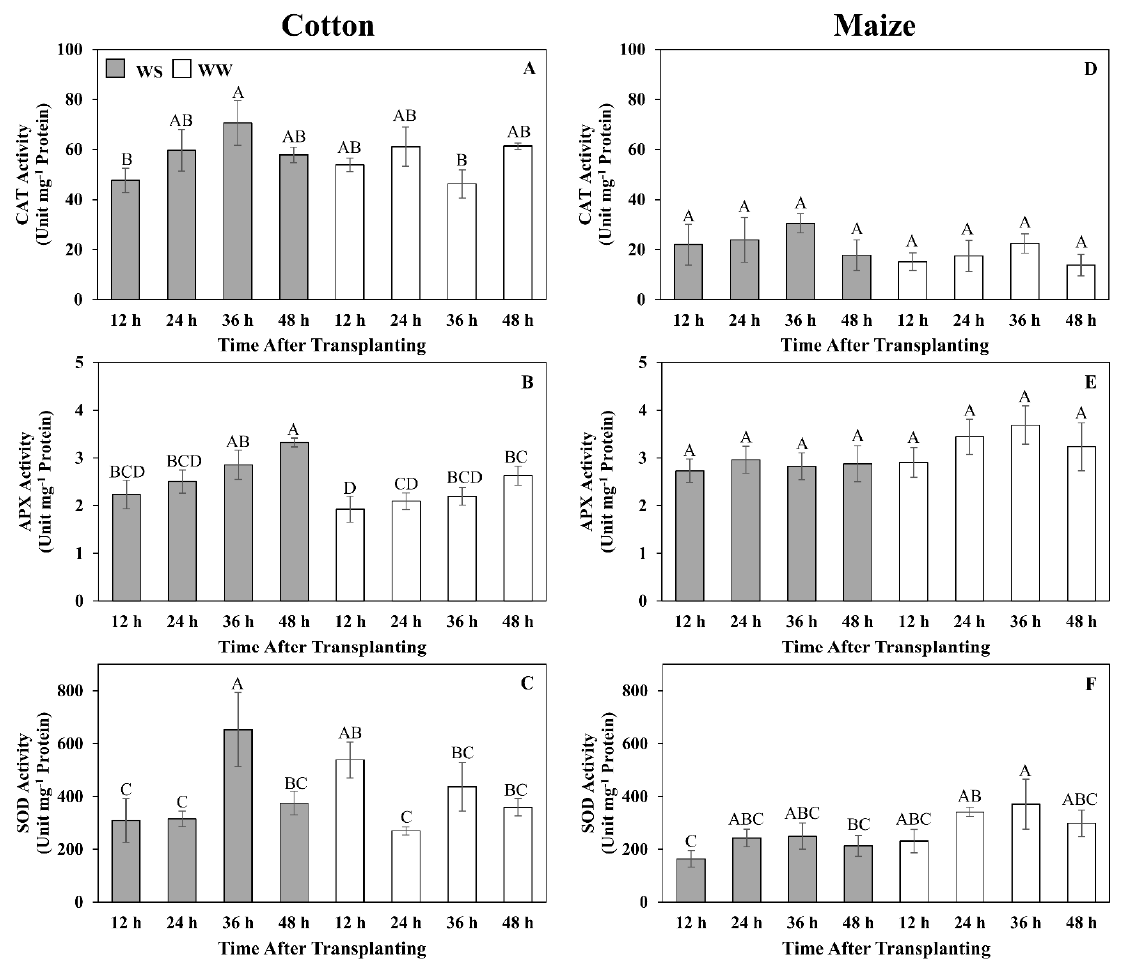
Figure 8. Time courses of catalase (CAT) ( A , D ), ascorbate peroxidase (APX) ( B , E ) and superoxide dismutase (SOD) ( C , F ) activities in the elongation zone of cotton ( A – C ) and maize ( D – F ) primary roots during 48 h after transplanting to water-stressed (WS, shaded bars) or well-watered (WW, open bars) conditions. In the water stress treatments, vermiculite water potentials were − 1.0 MPa (cotton) and − 1.6 MPa (maize), which resulted in equivalent root tip water potentials in the two species (Figure 2). The whole elongation zone was collected (see Figure 6 for dimensions). Data are the means ± SE ( n = 4). ANOVA analyses compare the data at different time points across treatments within each species; different letters indicate significant differences ( p < 0.05).